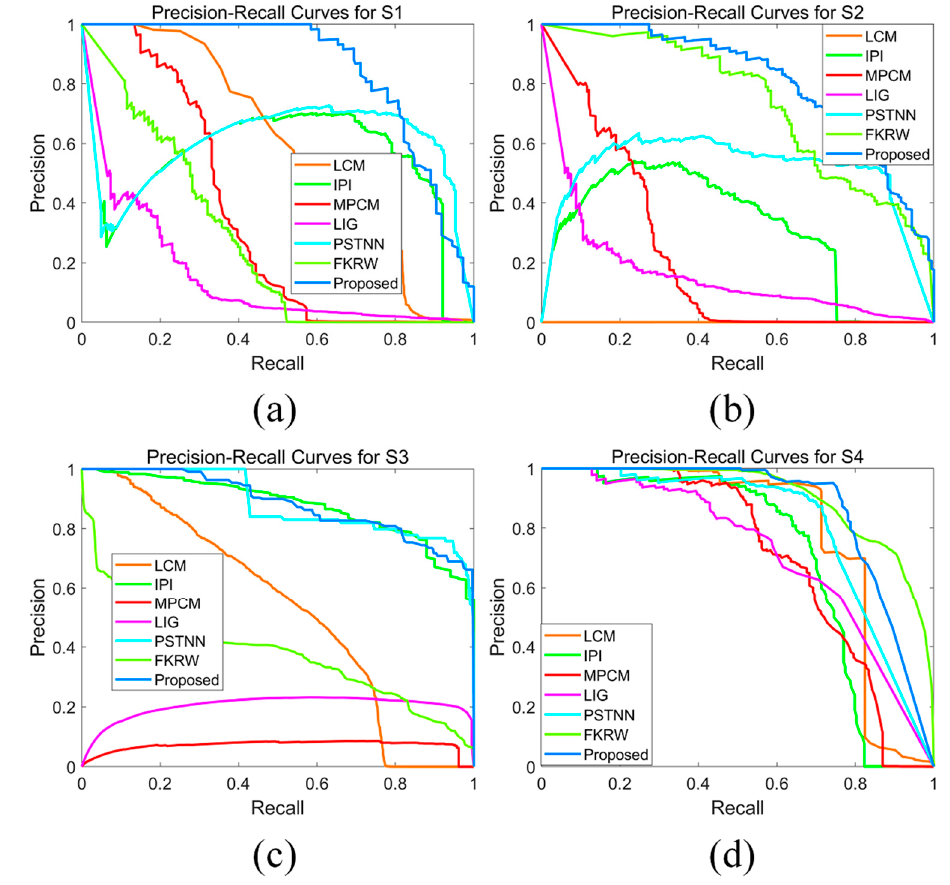
Figure 14. The PRC on different sequences: ( a ) PRC for S1, ( b ) PRC for S2, ( c ) PRC for S3, and ( d ) PRC for S4.